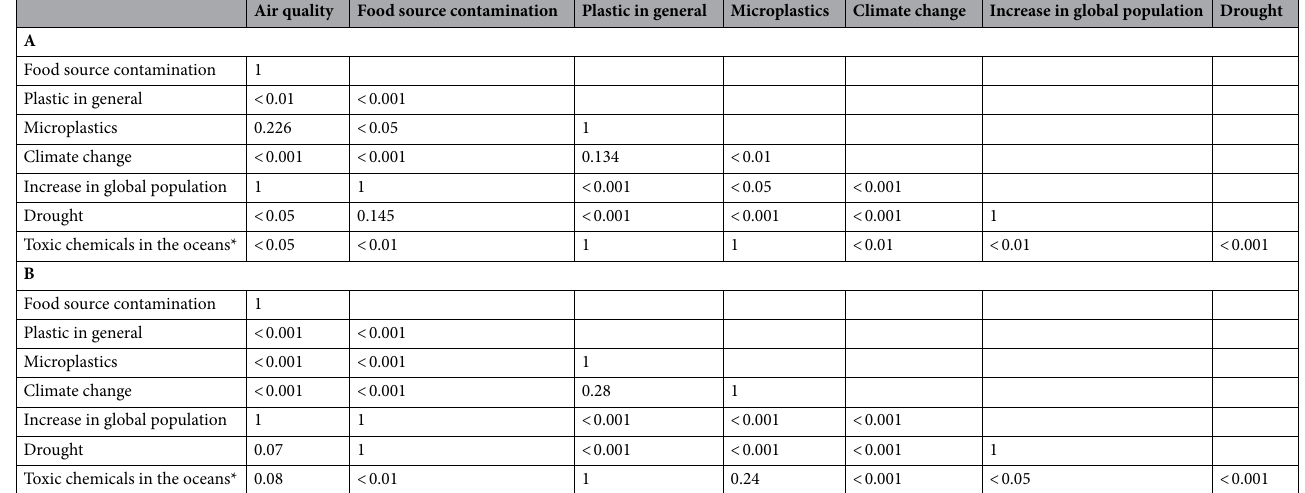
Table 1. Post-hoc analysis results: statistical significance between environmental concern rankings per group [(A) lay respondents, (B) topic-experienced respondents] analysed with pairwise comparison Wilcoxon signed rank tests and Bonferroni